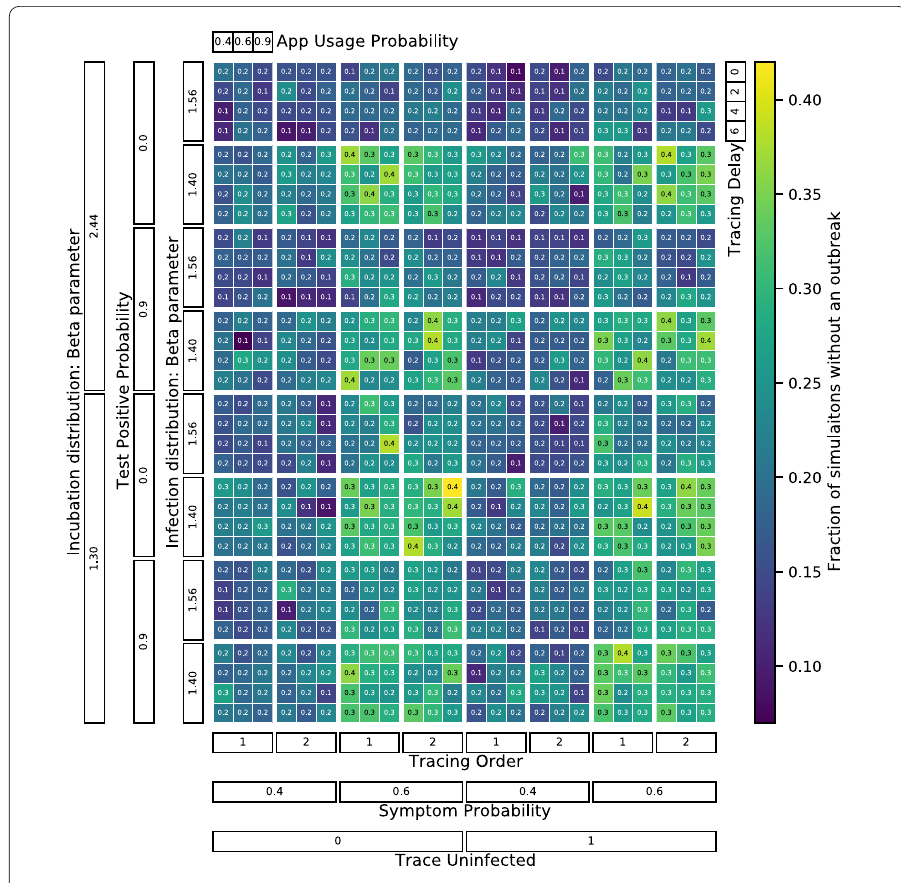
Figure 34 The fraction of MC runs where the outbreak stopped (by chance) before the threshold number of infected people to start interventions was reached (timing and delay parameter